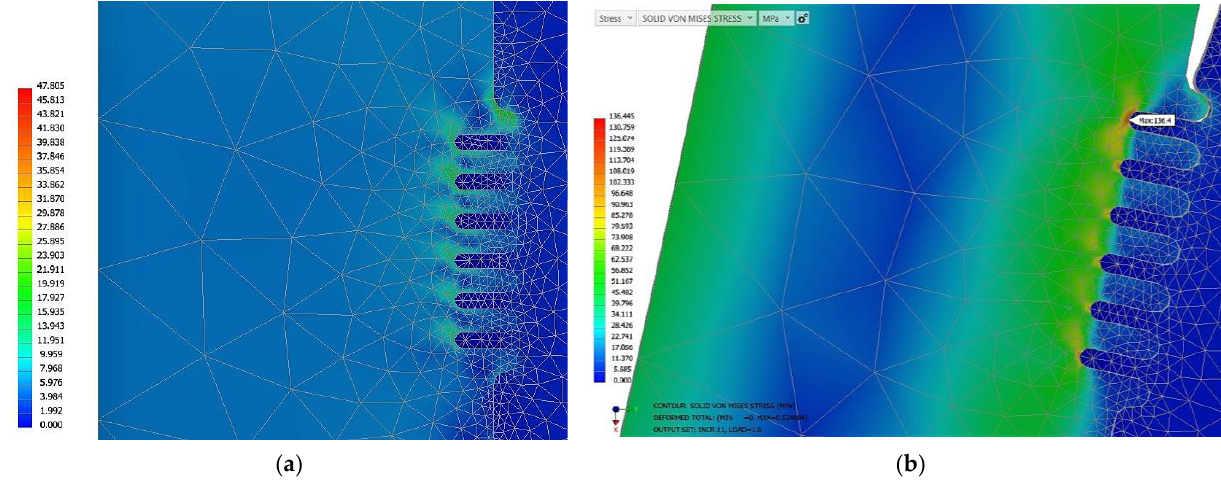
Figure 7. Zoomed comparison between: with fixture ( a ) and without fixture ( b ), regarding Von Mises stress (MPa) distribution.